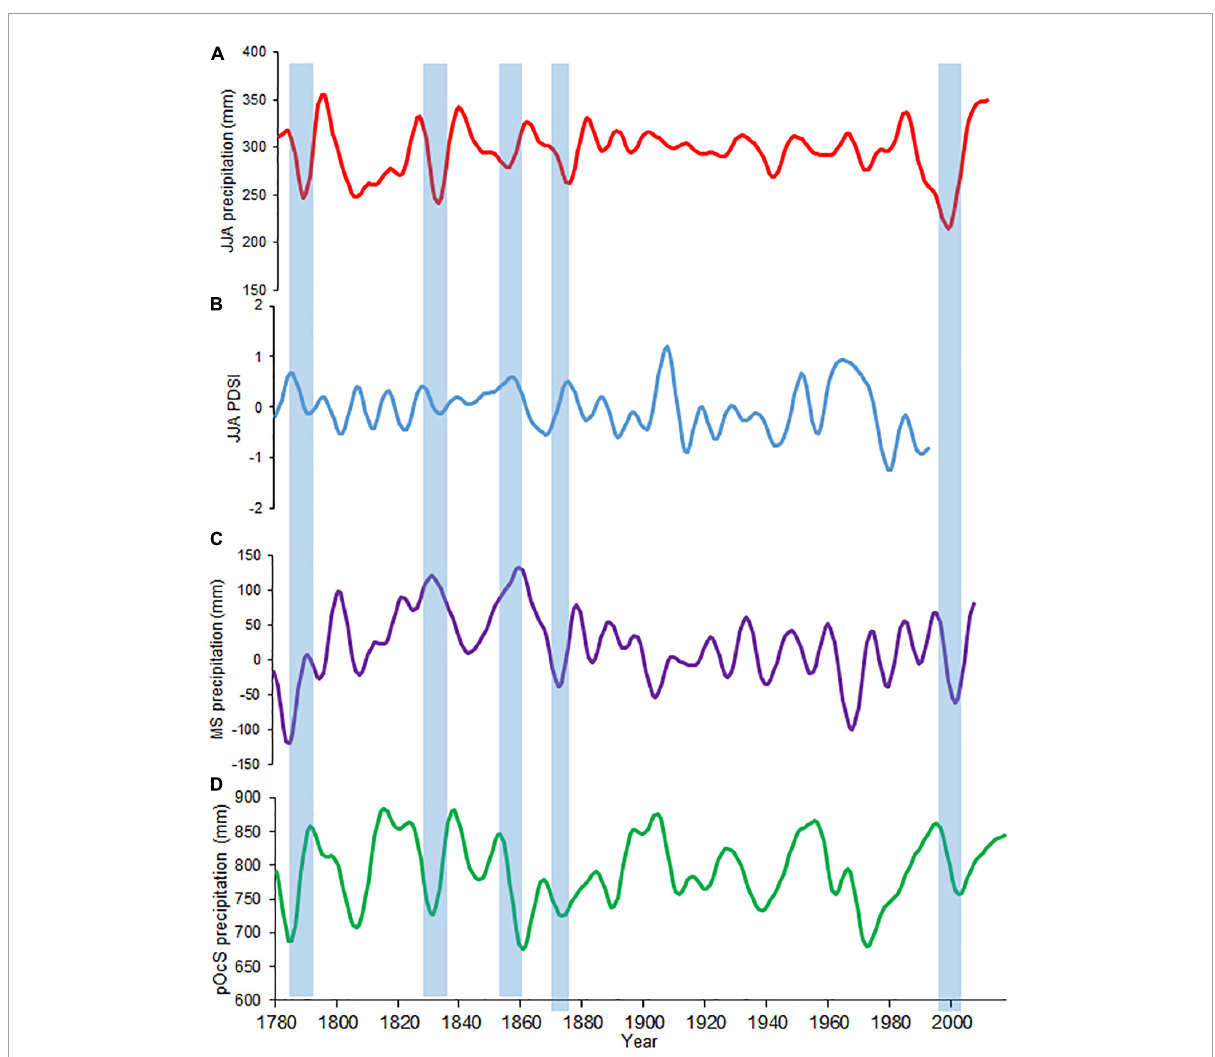
FIGURE8 Comparison of (A) reconstructed PPT JJA with (B) JJA PDSI reconstruction from Asia (Cook et al., 2010), (C) May–September (MS) precipitation reconstruction from Bhutan Himalaya (Sano et al., 2013), and (D) previous October–Current September (pOcS) precipitation reconstruction from Indian Western Himalaya (Singh et al., 2021). All the line plots are smoothed by a 10-year low-pass smoothing filter.